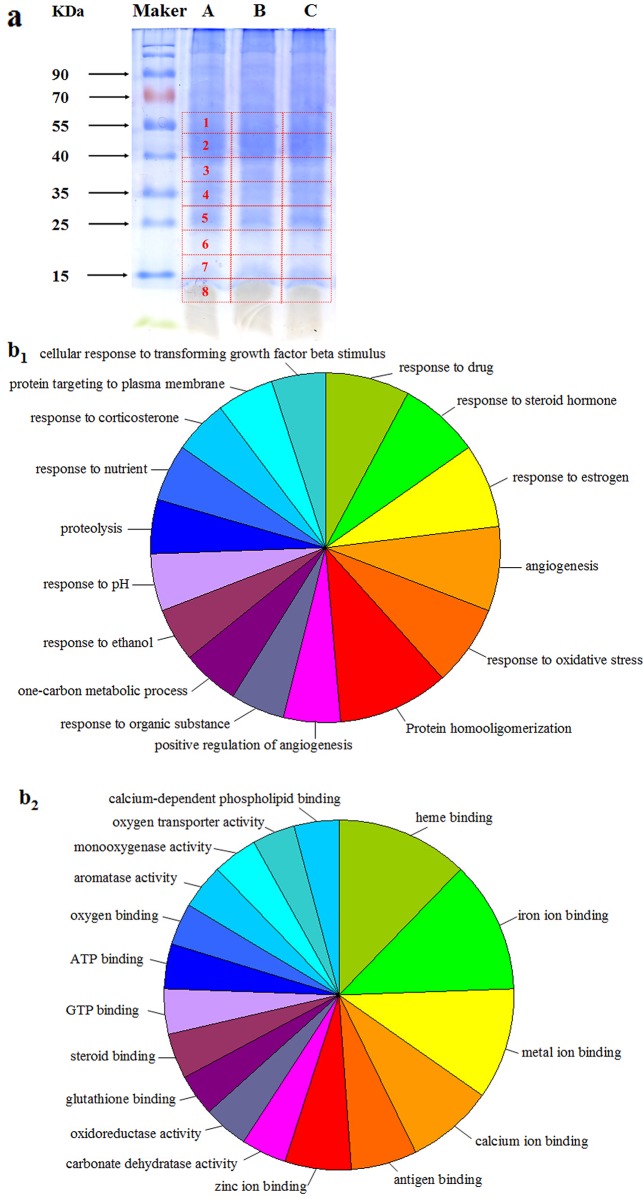
Proteomic analysis of differentially expressed proteins from rat liver in various study groups.Representative 12.5% SDS-PAGE gels (a) showing the total proteins pooled from (A) normal group (n = 3), (B) DMN model group (n = 3) and (C) ZYC-1 group (n = 3). The functional analysis of differentially expressed proteins was carried out by GO analysis database, for the Biological Process (b1), Molecular Function (b2).